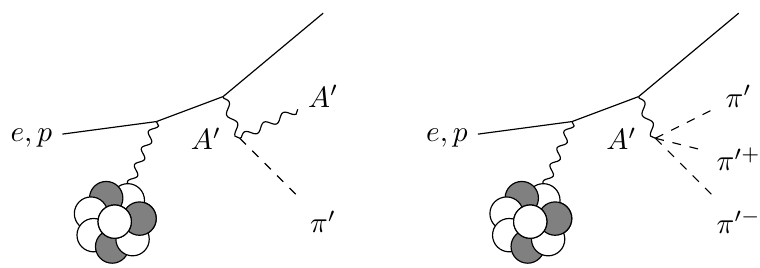
Figure 3 . Bremsstrahlung production of dark-neutral pions via off-shell dark